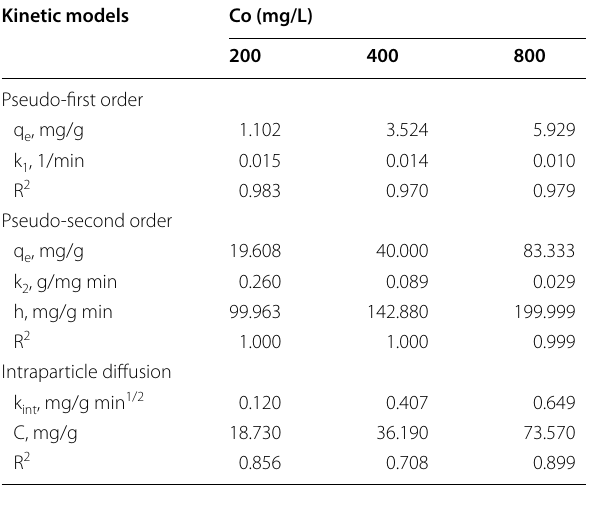
Table 3 Kinetic constants for removal of MG from aqueous solution by TLLP at different temperatures Kinetic models